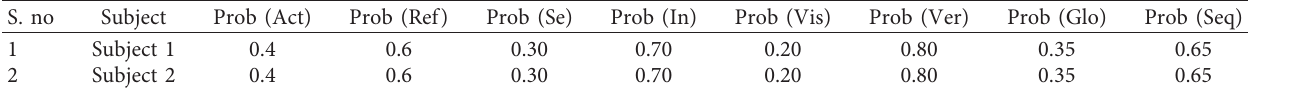
Table 6: Preference values